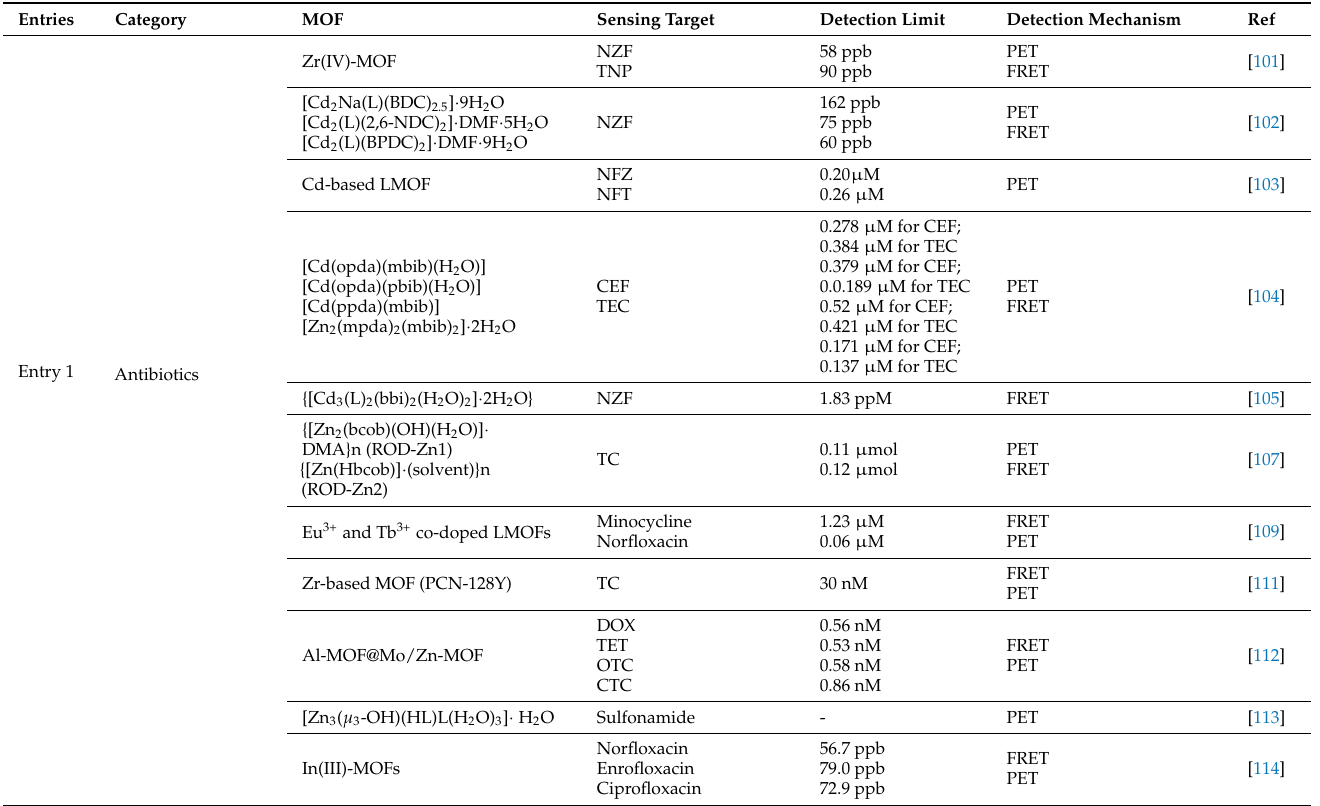
Figure 20. ( a ) Schematic representation of the synthesis of Zr-BTDB-fcu-MOF (1). ( b ) PL spectra for (1) (red) and linker (black). ( c ) Fluorescence intensity of (1) aqueous suspension upon addition of 3 µ M of of MA ( c ), aniline ( d ) ( λ max = 515 nm). ( e ) Molecular structures of H 2 BTDB, H 2 BTDB with two and four MA molecules. Red arrows represent the dihedral angles between benzene and thiadiazole-based units, and red dashed lines indicate the hydrogen-bond lengths (dH) formed by H of MA and N of thiadiazole Adapted from [146]. Table 3. The hazardous organic pollutant detection ability and detection mechanisms of various LMOF-based